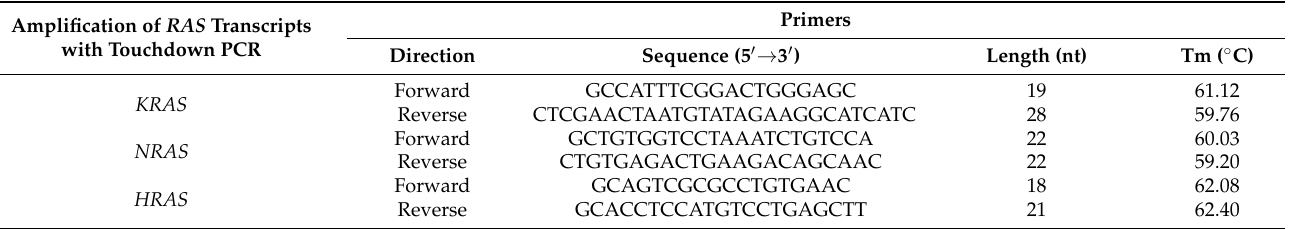
Table 1. List of primers that were used for the specific amplification of the RAS mRNA transcripts with touchdown PCR. The melting temperature (T m ) of each primer was calculated by Primer-BLAST designing tool. Amplification of RAS Transcripts with Touchdown